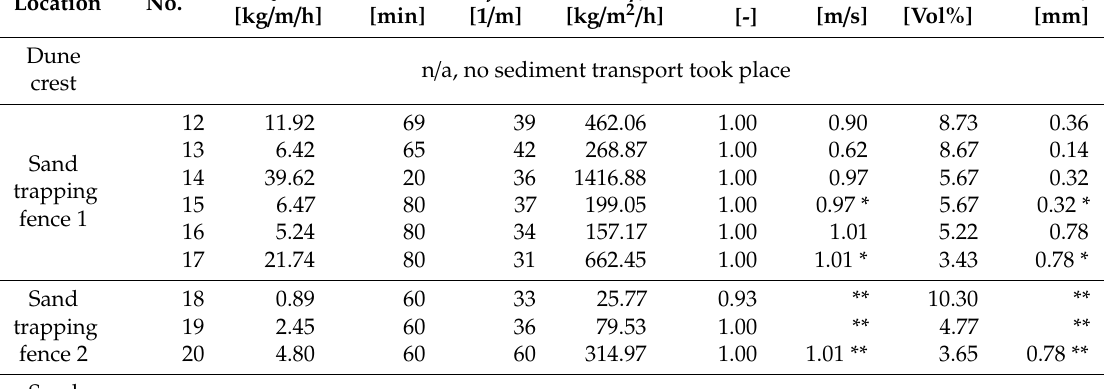
the law of the wall